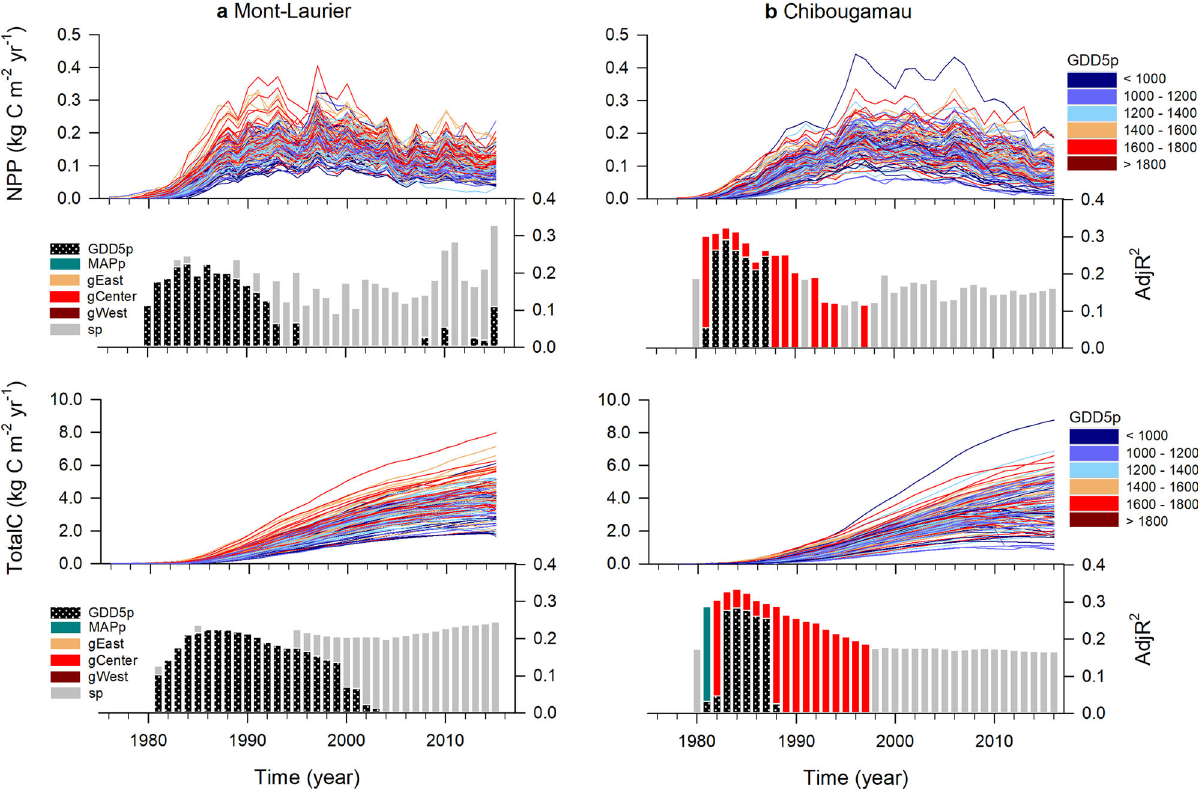
Fig. 2 Annual changes in composite phenotypes. Time-series plots: annual aboveground net primary production (NPP) and total carbon (TotalC, i.e. cumulated NPP), at the population level by block, at the a Mont-Laurier and b Chibougamau common garden sites. The color scheme indicates the mean annual growing degree days above 5 °C at provenance (GDD5p) seed sources. Vertical bars: Results of generalized additive models (GAM) for population differentiation and clinal variations in annual NPP. A high adjusted R 2 (AdjR 2 ) value denotes a high goodness-of- fi t between NPP and the explanatory variables GDD5p, mean annual precipitation (MAPp), admixture proportions along Western, Central, and Eastern genetic clusters (gWest, gCenter, gEast), and spatial factors (sp) represented by the distance-based Moran ’ s eigenvector maps. The number of sampled independent populations in GAM analysis was n = 42 for Mont-Laurier and n = 45 for Chibougamau, each having three replicates. All shown variables are signi fi cant at the two-sided 5%